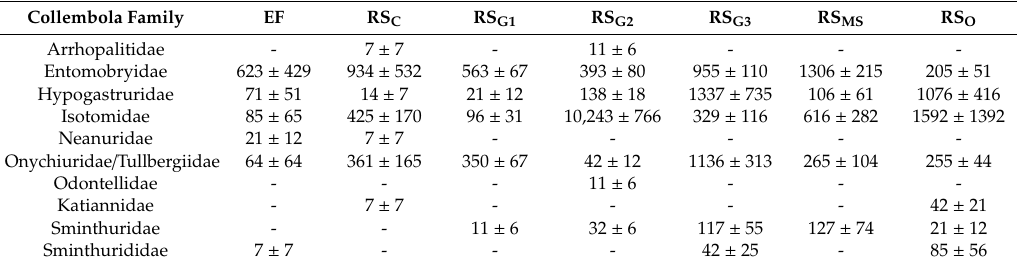
Table 3. Average ± standard error of the number of Collembola per m².